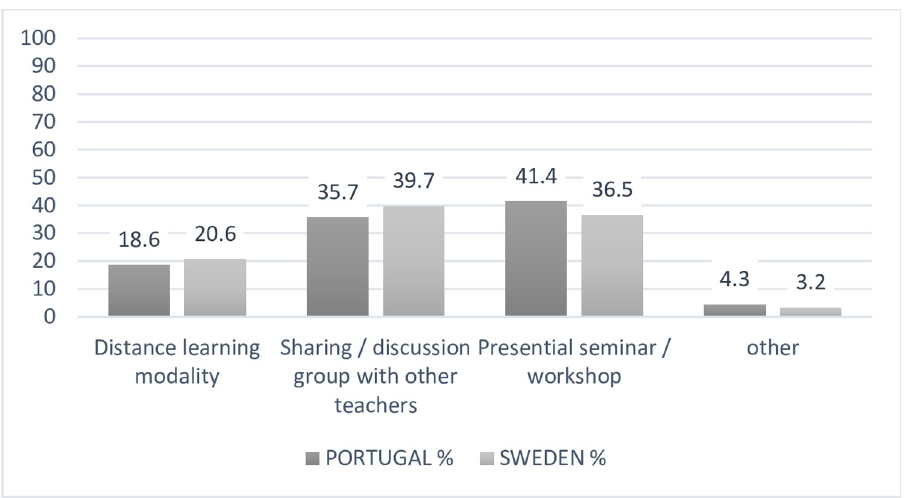
Fig 8. Training modalities selected by teachers (N =